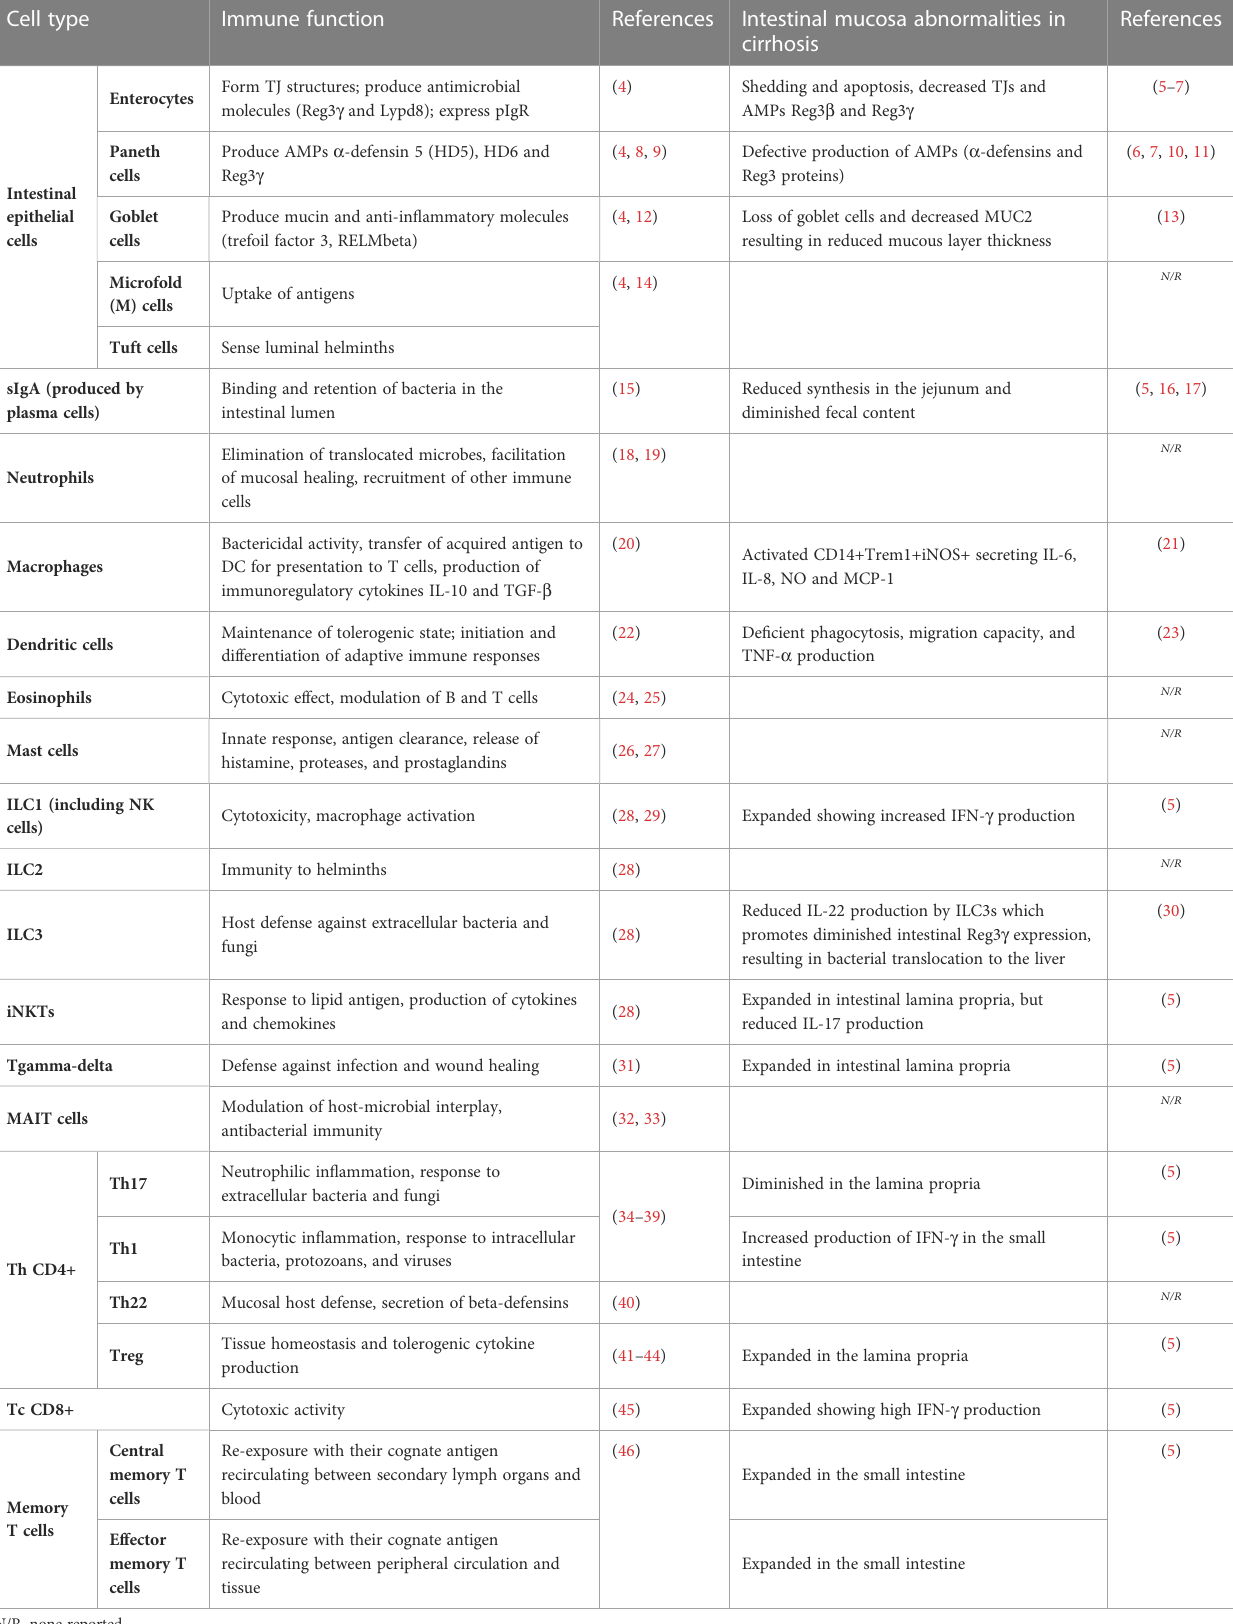
TABLE 1 Role of immune cells involved in gut homeostasis and abnormalities produced in